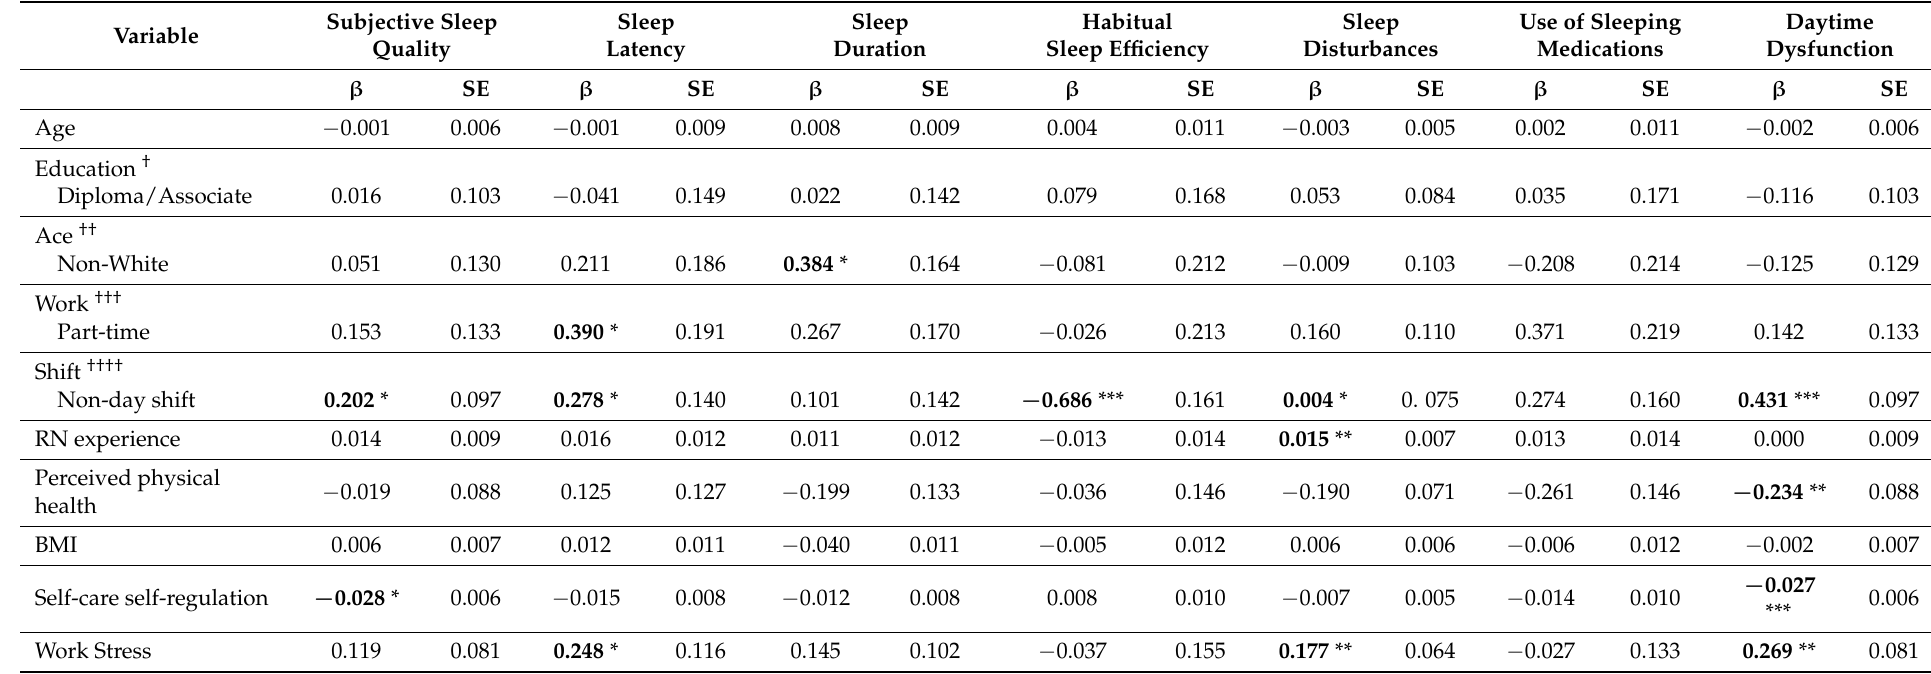
Table 4. Multivariate regression for variables associated with sub-components of PSQI ( n =